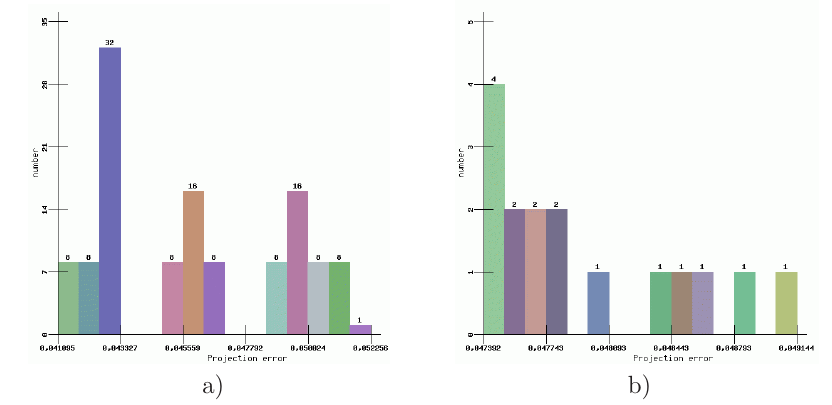
Figure 7. Distribution of the projection error on the basis of the fixed experiments (using Relative MDS, PCA initialization method, 1000 iterations): (a) Ellipsoidal, (b) Sphere data